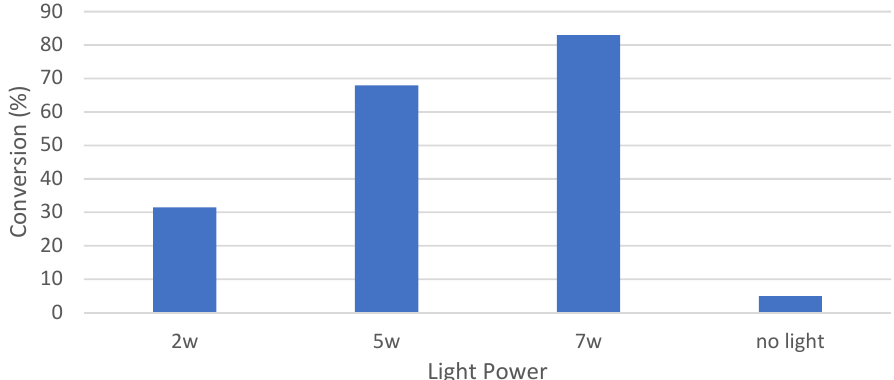
Figure 13. Optimization of light power for the oxidation of vanillyl alcohol to VN. Reaction conditions: 1 mmol vanillyl alcohol, 0.4 mol% NiFe 2 O 4 , air, rt, 10mL solvent, 0.8 mol.% TEMPO, base 2 equiv., and 6 h reaction time. Conversion was determined by GC analysis using 1,2-dichlorobenzene as the internal standard.